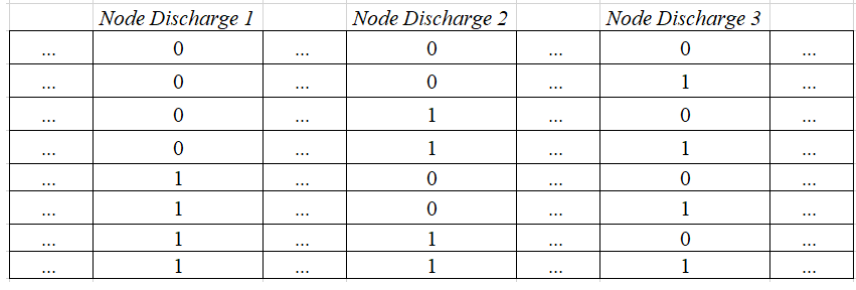
Figure 7. Population Cconfiguration